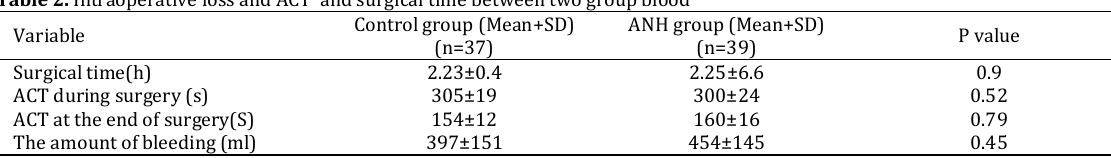
J Cardiothorac Med. 2017; 5(4): 226-231.